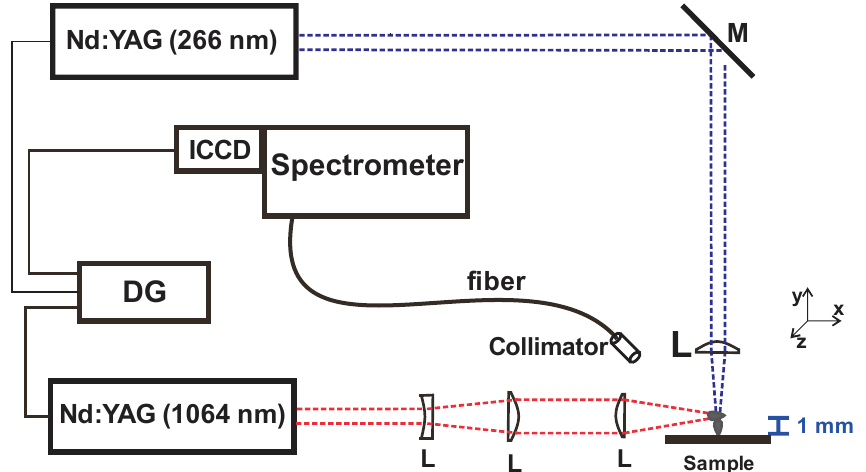
Figure 1. Experimental arrangement employed for orthogonal DP-LIBS in reheating configuration.